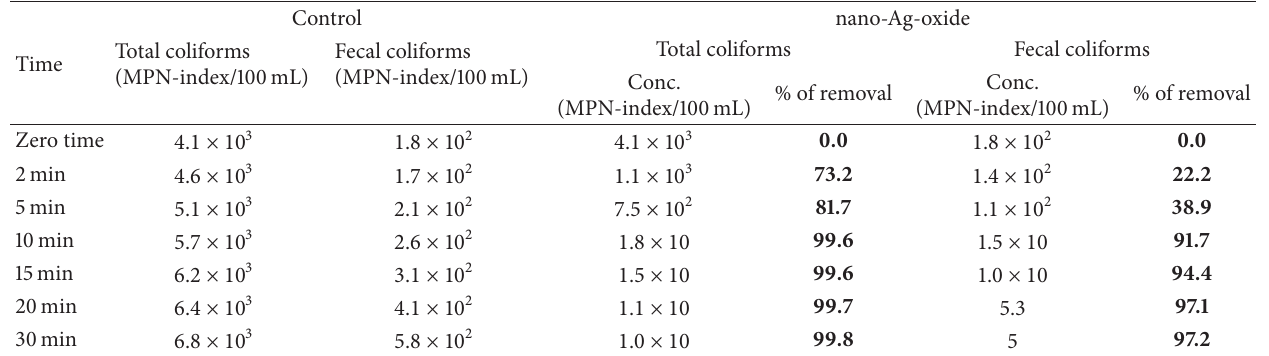
Table 4: Effect of contact time for reduction of total and fecal coliforms from secondary treated effluent using nano-Ag-oxide.